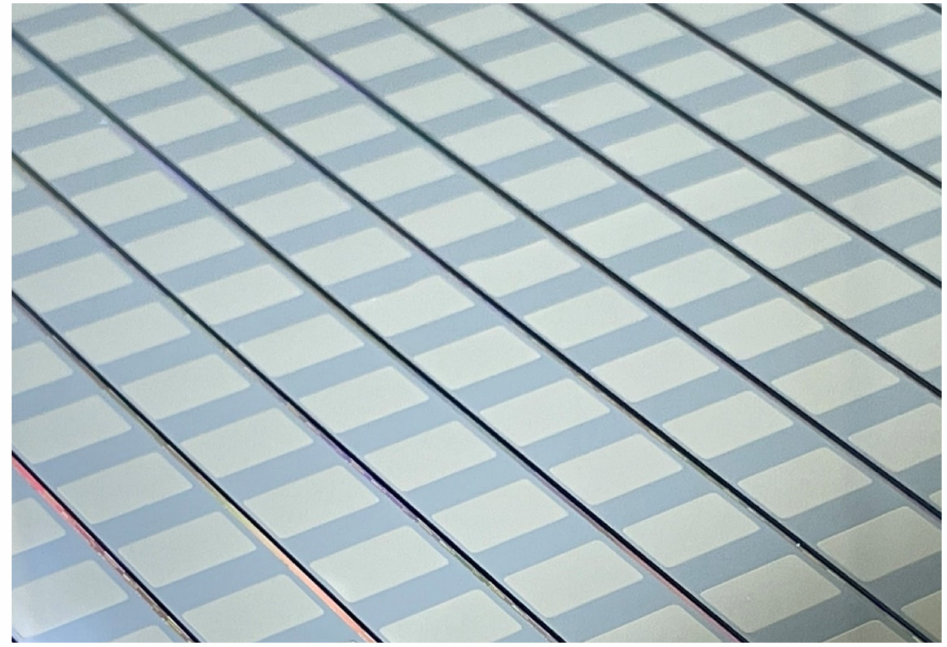
Figure 11. Wafer-level packaged wafer with opened electrical